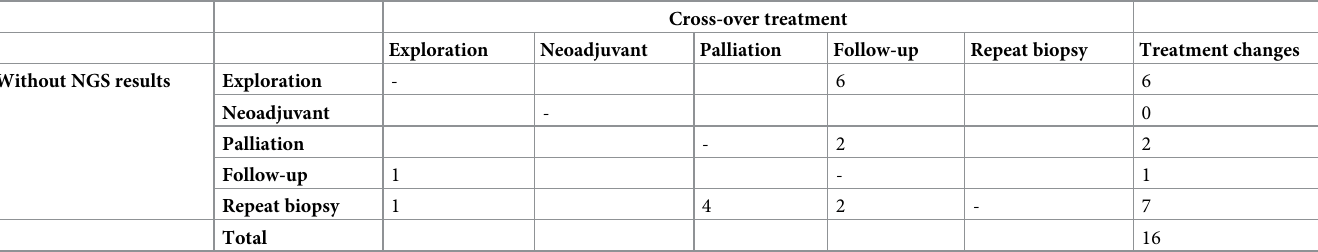
Table 3. Changes in treatment plan after NGS integration.